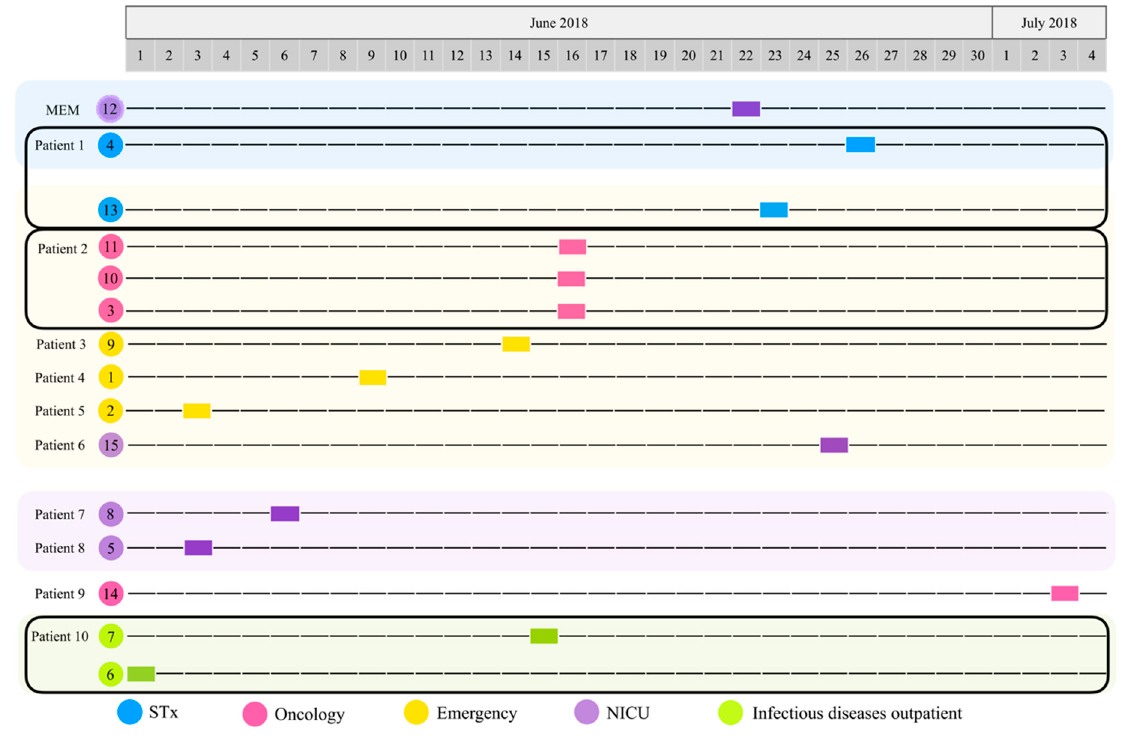
Figure 1. Timeline of the isolation of P. aeruginosa strains. Hospital ward: surgical therapy (STx, blue), oncology (pink), emergency (yellow), neonatal intensive care unit (NICU, purple), infectious diseases outpatient (I, green). Patients with two or more isolated strains are highlighted with a black rectangle (Patient 1: strains 4 and 13; Patient 2: strains 11, 10, and 3; Patient 10: strains 7 and 6).